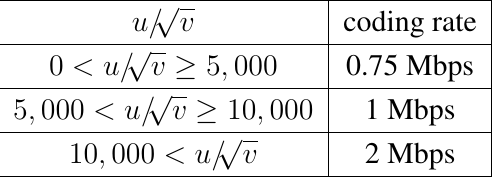
Table 3 . Mapping from concentrations of morphogens to coding